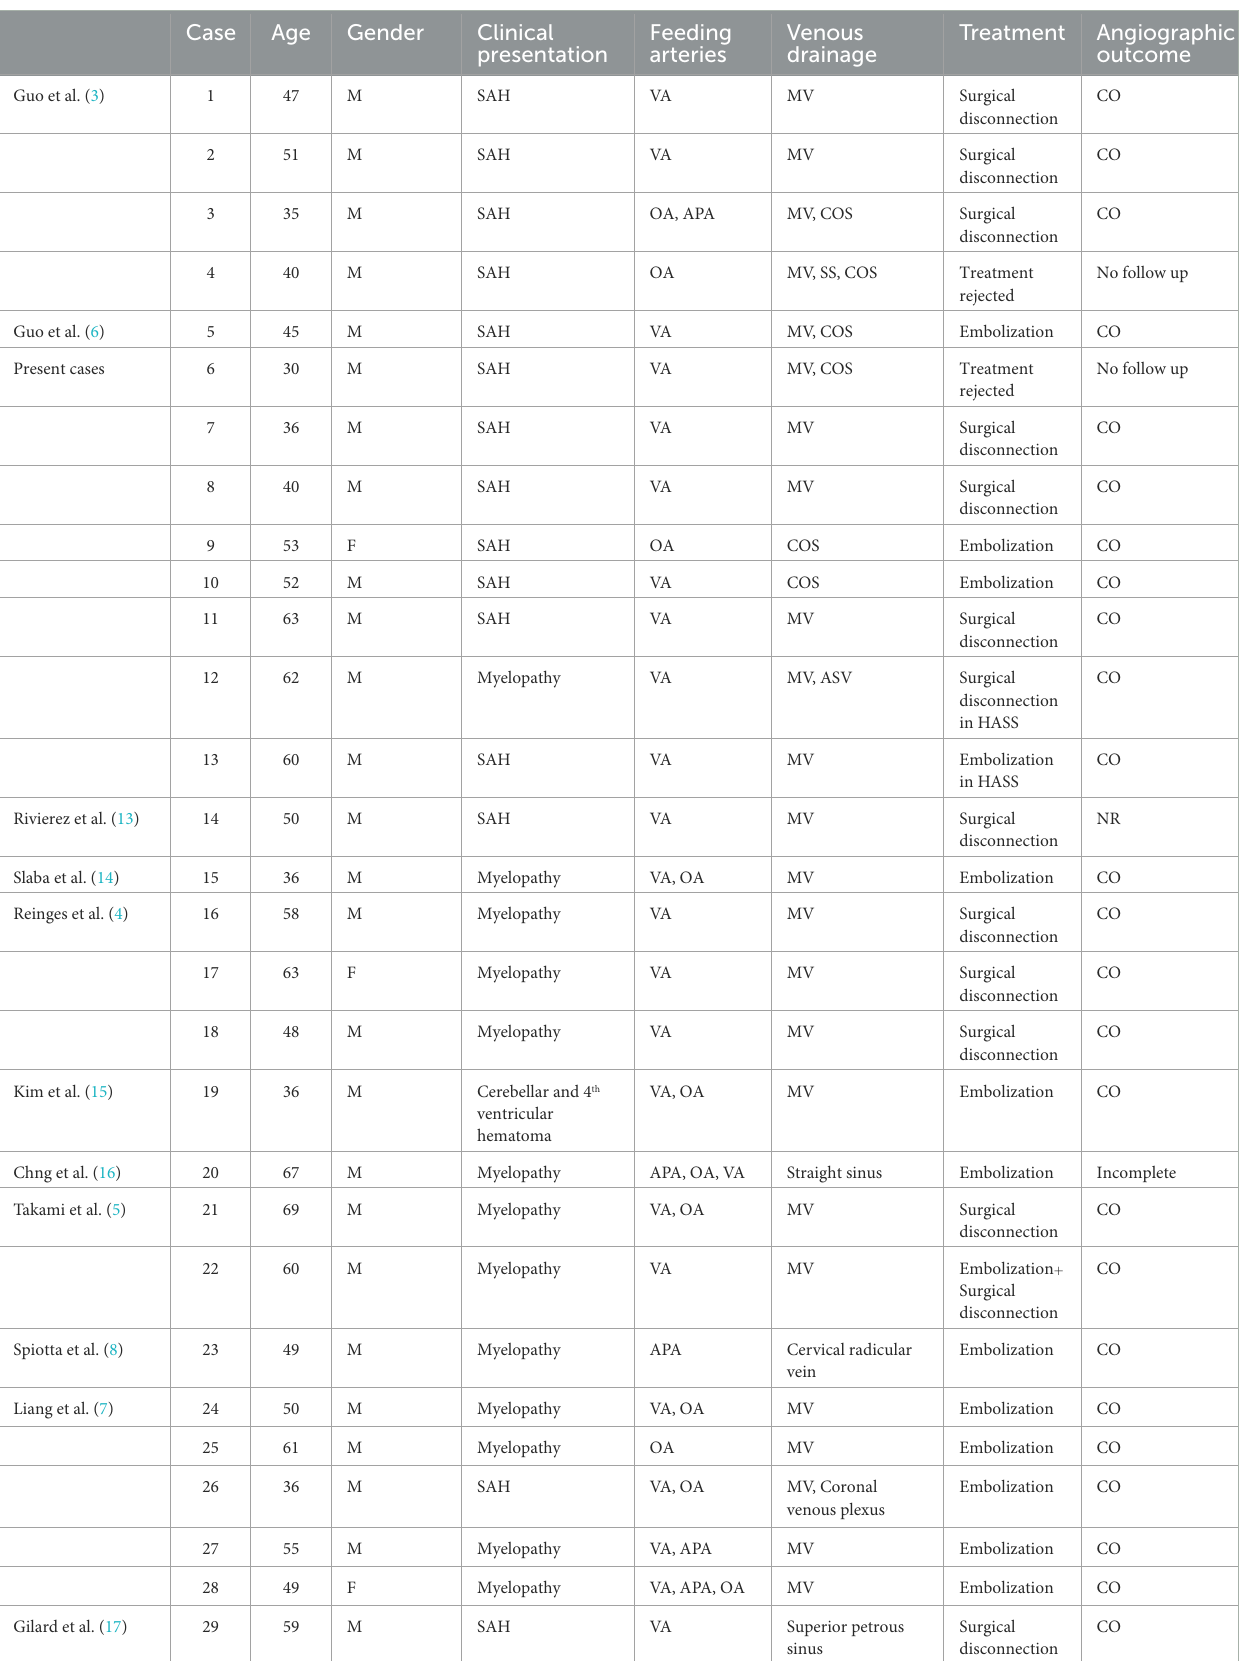
TABLE 1 Clinical and angioarchitectural characteristics and treatments of foramen magnum DAVFs. Case Age Gender Clinical